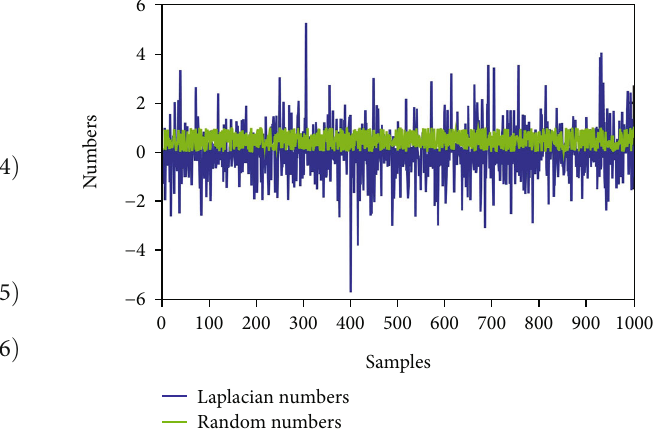
Figure 4: Comparison of random number generation by using the uniform distribution and Laplace